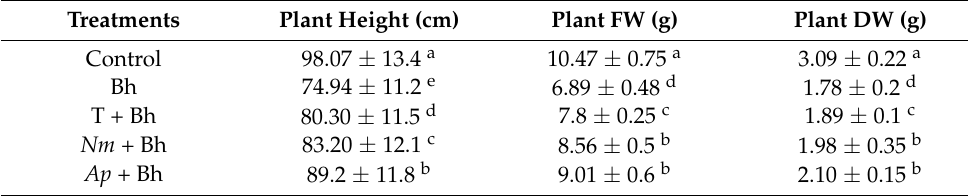
Table 1. Effect of different safener treatments on growth parameters of wheat plants *.